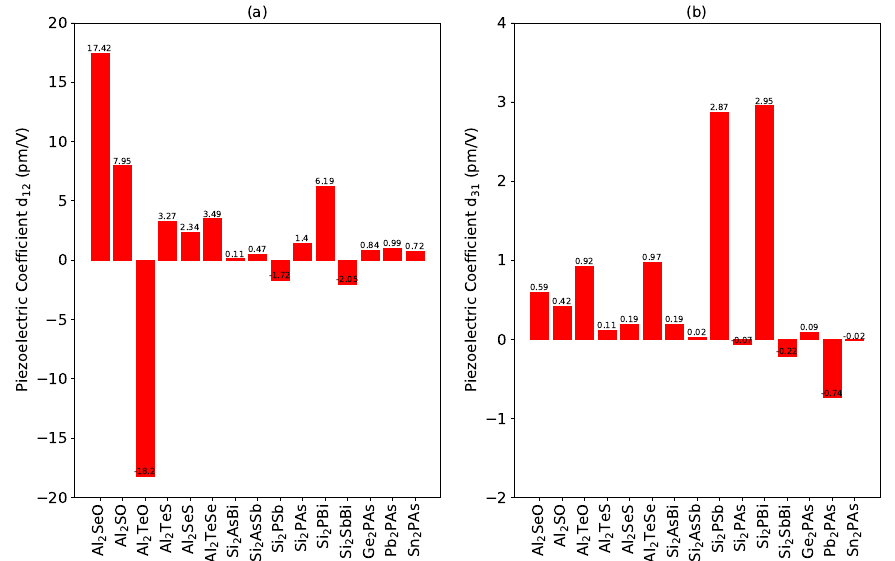
Figure 5. Piezoelectric coefficients ( a ) d 12 and ( b ) d 13 of 15 different structures of A 2 XX’